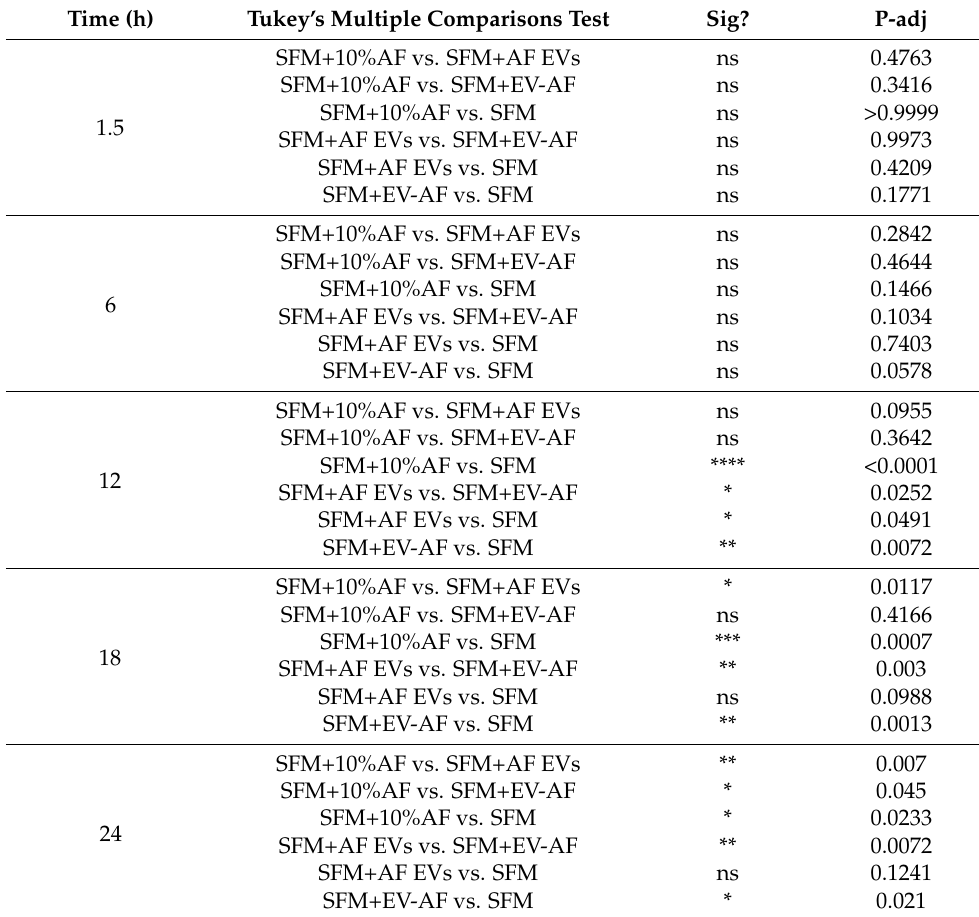
Table 1. Two-way ANOVA of scratch test assay data from Figure 6E. ns = not significant, * p <